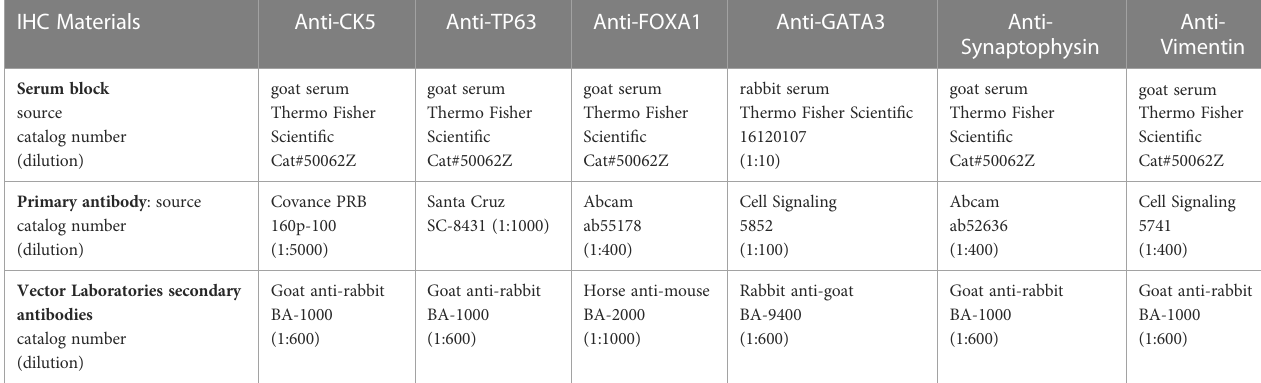
TABLE 1 Immunohistological staining reagents, sources and